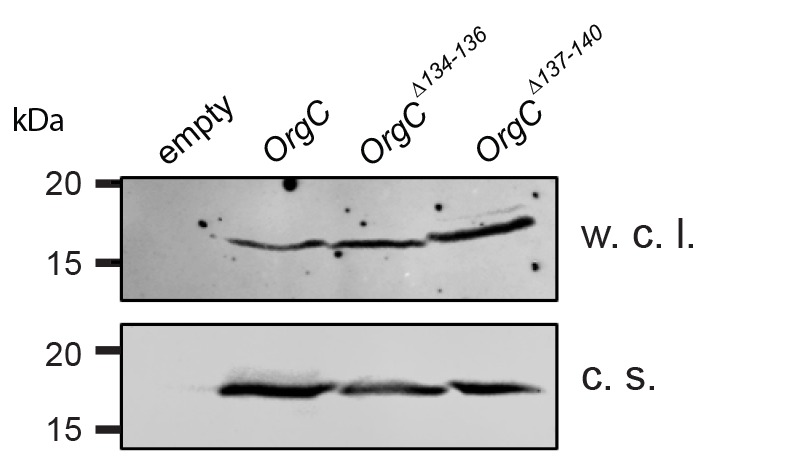
Stability of the OrgC protein deletion mutants.Whole cell lysates (w. c. l.) or culture supernatants (c. s.) of S. Typhimurium ΔinvJ ΔorgC mutant strains carrying the empty vector pWSK129 (empty) or expressing the indicated carboxy-terminal FLAG-epitope-tagged OrgC deletion mutants were analyzed by immunodetection using antibodies directed to the FLAG tag. All variants were produced and secreted at equivalent levels.